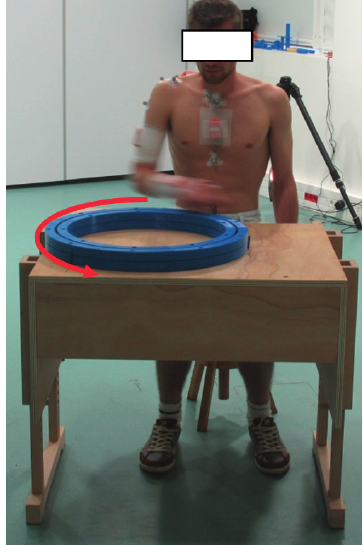
Figure 3. Illustration of the wheel